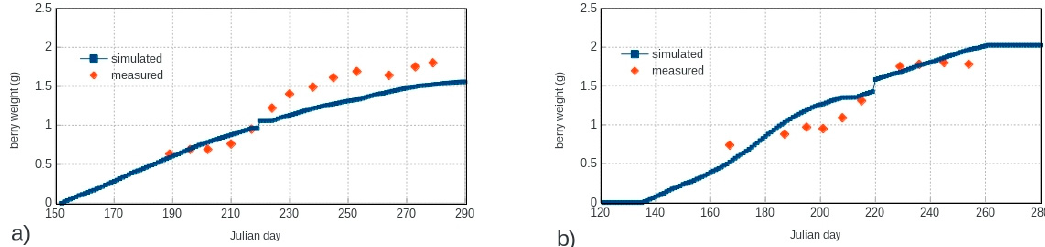
Figure 3. Comparison between simulated and measured berry weight (g) in the Castagnito site during 2005 ( a ), and in the Castagnito site during 2007 ( b